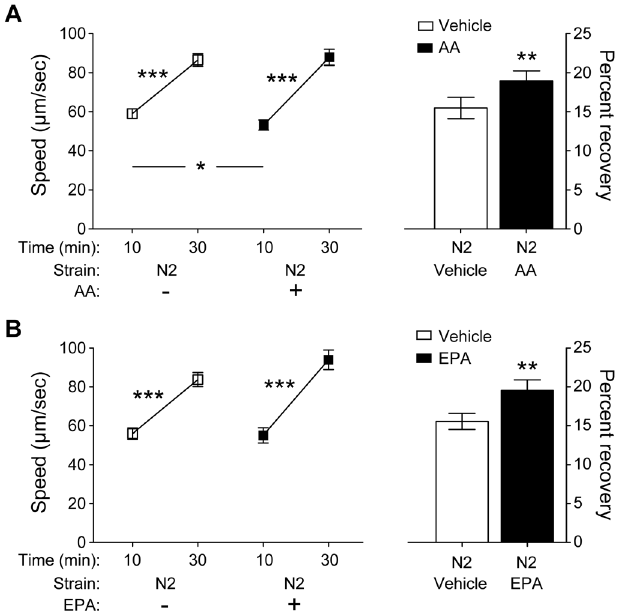
Figure 4. Dietary supplementation of AA or EPA can enhance the development of AFT in wild-type animals. All trials in which N2 was supplemented with AA or EPA are shown, n =21 for AA, n =18 for EPA. (A) N2 animals supplemented with AA demonstrate increased initial sensitivity to ethanol and enhanced development of AFT. (B) N2 animals supplemented with EPA demonstrate enhanced AFT. Error bars represent SEM. * p , 0.05; ** p , 0.01; *** p , 0.001.